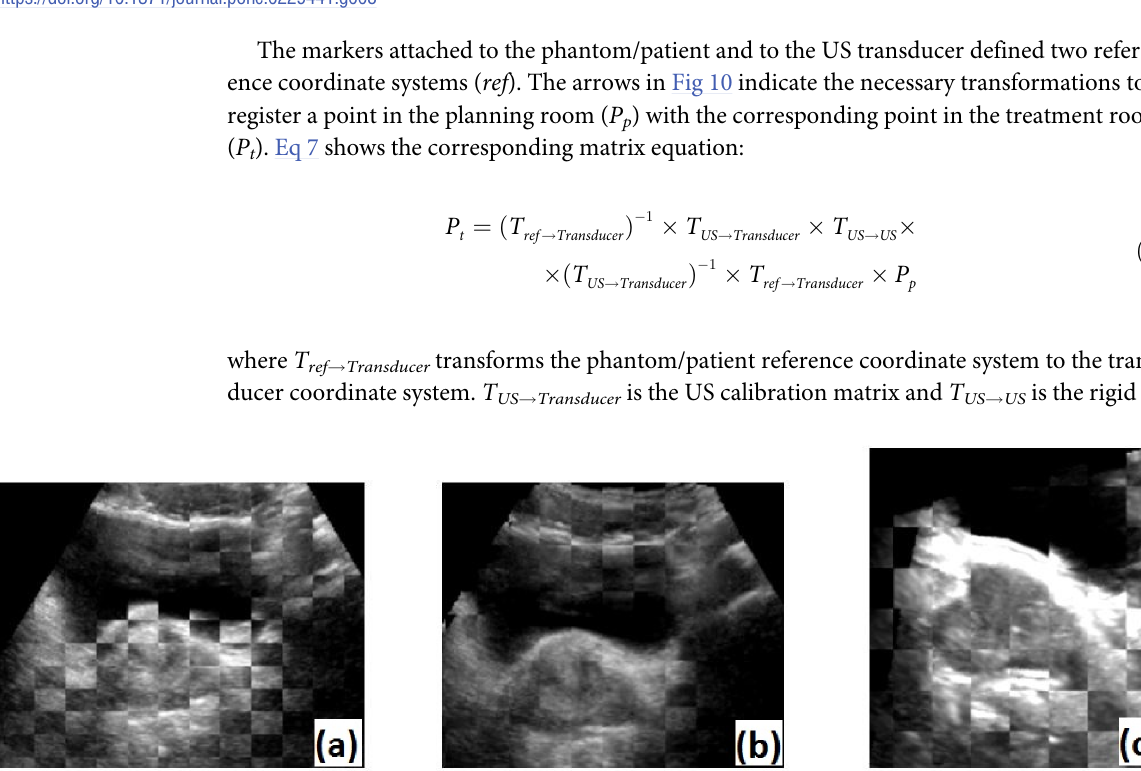
Fig 9. Checkerboard image of prostate images with 3D Slicer: (a) shows the the unaligned images and (b) the images after alignment using the US calibration using the 3D wobbler mode . In (c) the 3D free-hand reconstructed volumes were aligned.